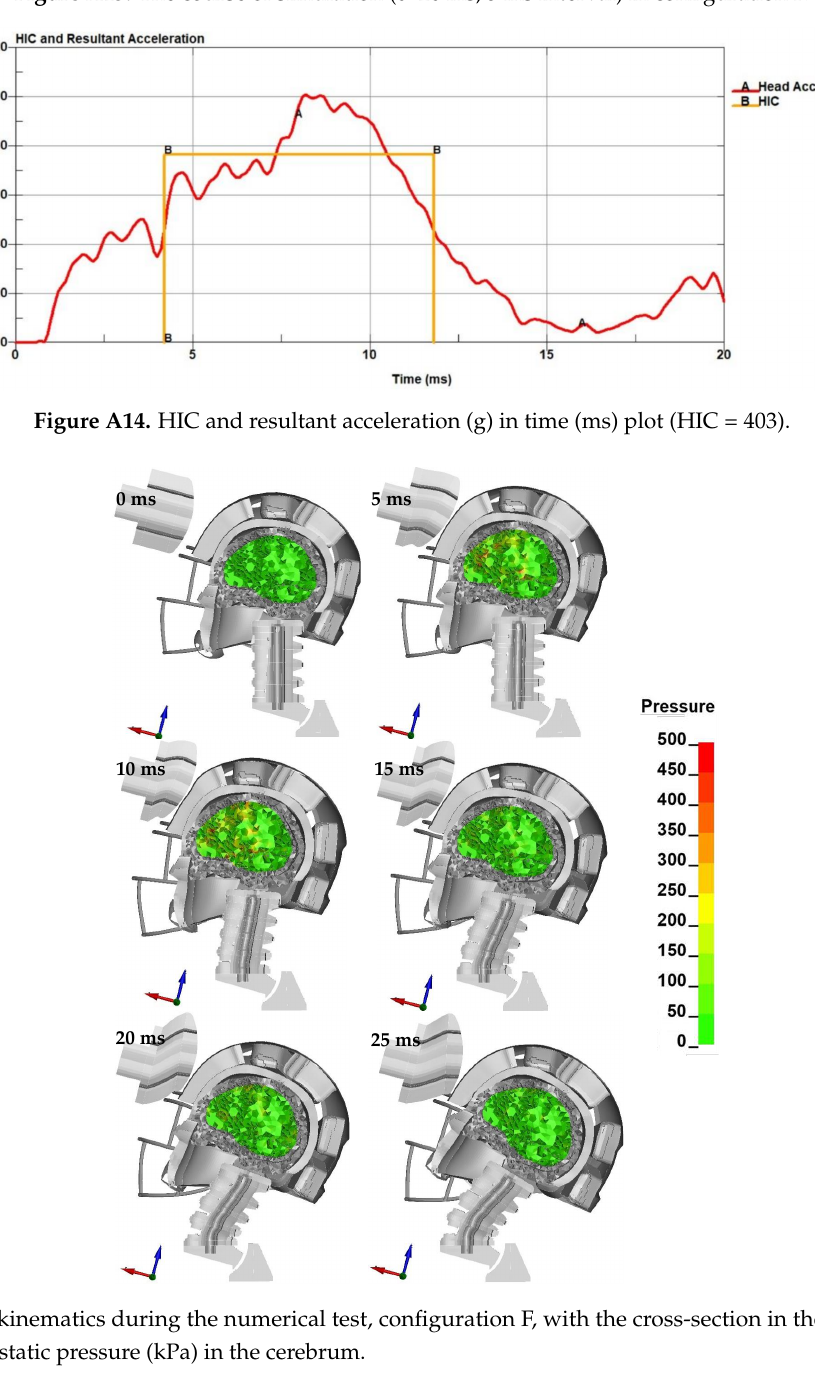
Figure A13. The course of simulation (0–20 ms, 5 ms interval) in configuration F.